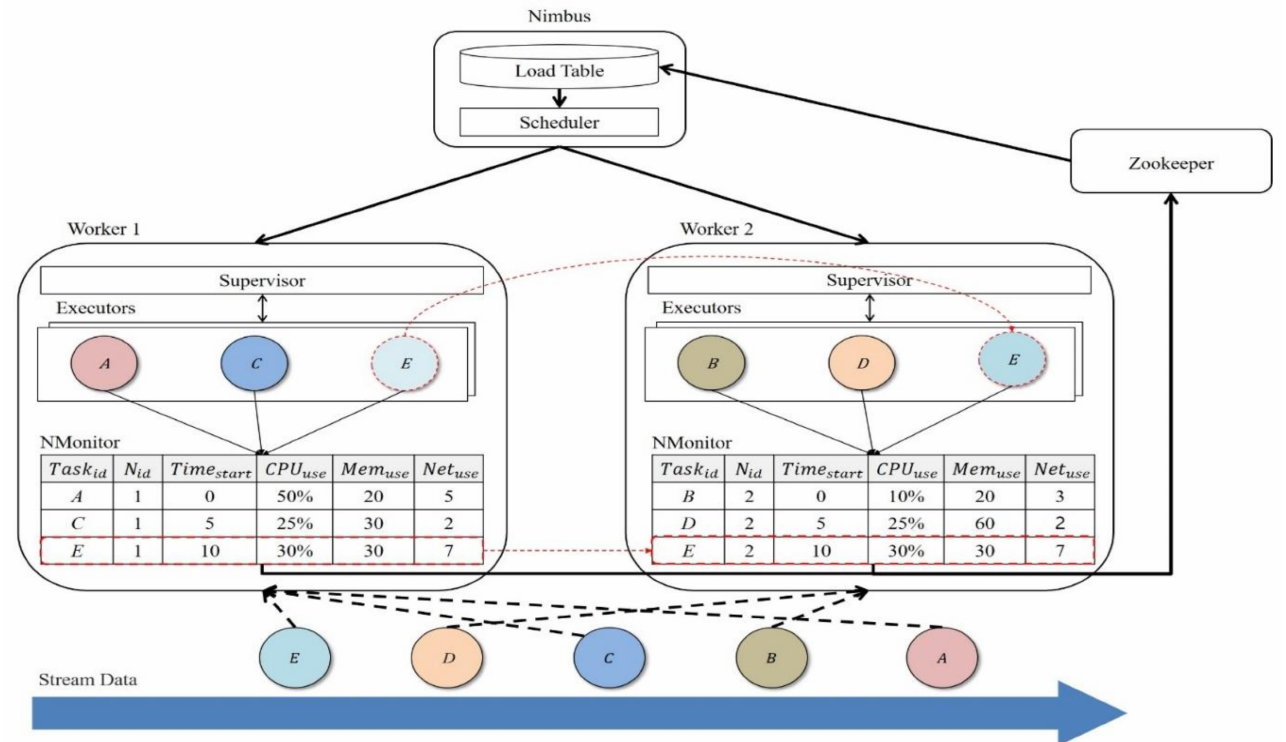
Figure 1. Overall architecture of the proposed local event detection scheme. Figure 2 illustrates the overall processing procedure of the proposed scheme. When stream data are input, Nimbus, which is the master node, checks the loads using a load management module. Static scheduling is performed if the load is below a threshold, whereas dynamic scheduling is performed if the load exceeds the threshold. Static task scheduling uses R-Storm, developed in a previous study [12]. Dynamic scheduling is performed based on the load types, which are memory load, CPU load, and CPU/memory load. Dynamic scheduling redistributes the tasks based on the deadlines of the tasks being processed and allocates the newly input tasks to suitable worker nodes. Each worker node collects the information of the state and the tasks as well as the task throughput in real time. The data are collected as the NMonitor of each worker node sends task information and processing costs to the zookeeper node. Subsequently, the zookeeper node updates the load table of Nimbus every time the load state of a worker node changes based on the delivered information. Nimbus consistently performs static and dynamic scheduling based on the load